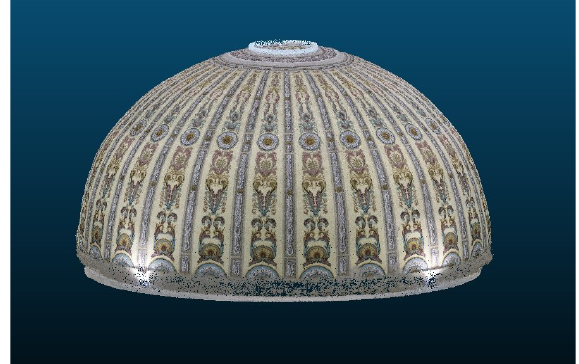
Figure 9: Photoscan dense point cloud.